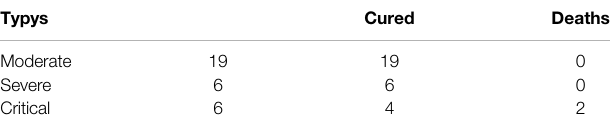
TABLE3| Recoveryrateofmoderate/severe/criticalcasesinthetreatmentgroup. Typys